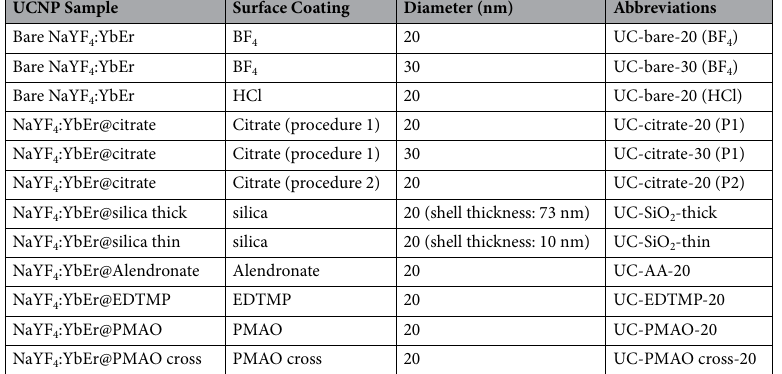
Table 1. NaYF 4 :Yb,Er surface modifications studied, including surface coating, size and the abbreviations used in the